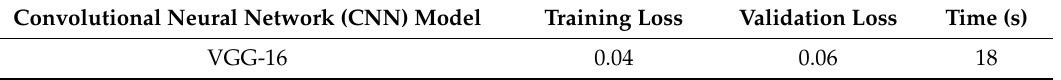
Figure 12. Performance of convolutional neural network (CNN): ( a ) training and validation losses, ( b ) training and validation accuracies. Table 3. Training and validation losses and training time for one epoch.